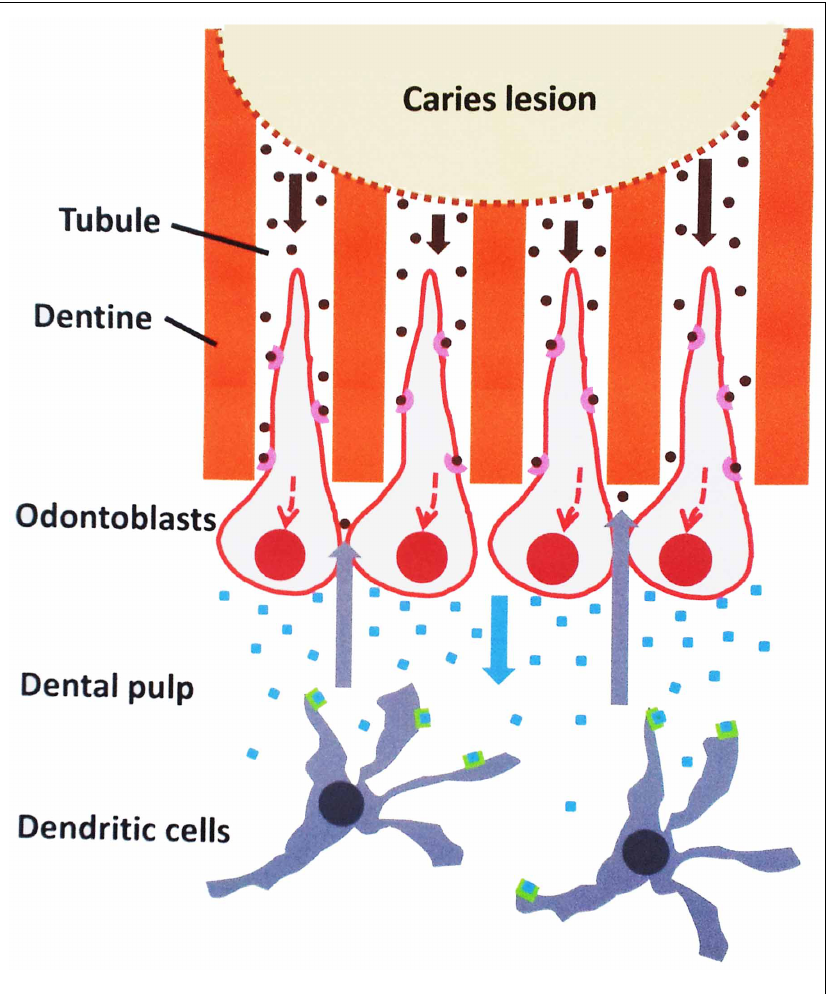
FIGURE 1 | Possible role of odontoblasts in the initiation of the dental pulp immune response to cariogenic bacteria. Oral bacteria that degrade dentine during carious lesions release pathogen-associated molecular patterns (PAMPs; brown dots) that may diffuse through the tubules to the odontoblast layer (brown arrows). Here, they are recognized by specific pathogen recognition receptors (pink cups) present at the odontoblast surface. Activation of specific intracellular pathways (dotted red lines) leads to the production of pro-inflammatory mediators including chemokines (blue squares) secreted at the opposite pole of the cell. These chemokines diffuse in the subodontoblast pulp area (blue arrow) and, upon binding to specific receptors (green boxes) attract antigen-presenting immature dendritic cells that ensure tissue immunosurveillance. These cells migrate to the odontoblast layer (gray arrows) to capture PAMPs arriving at the tubule pulpal end and develop the immune response and the associated